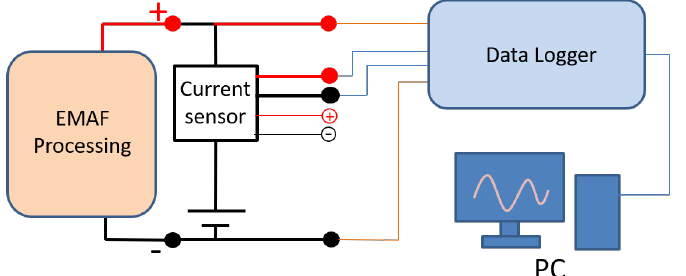
Figure 4. Schematic of current measuring and recording set up.